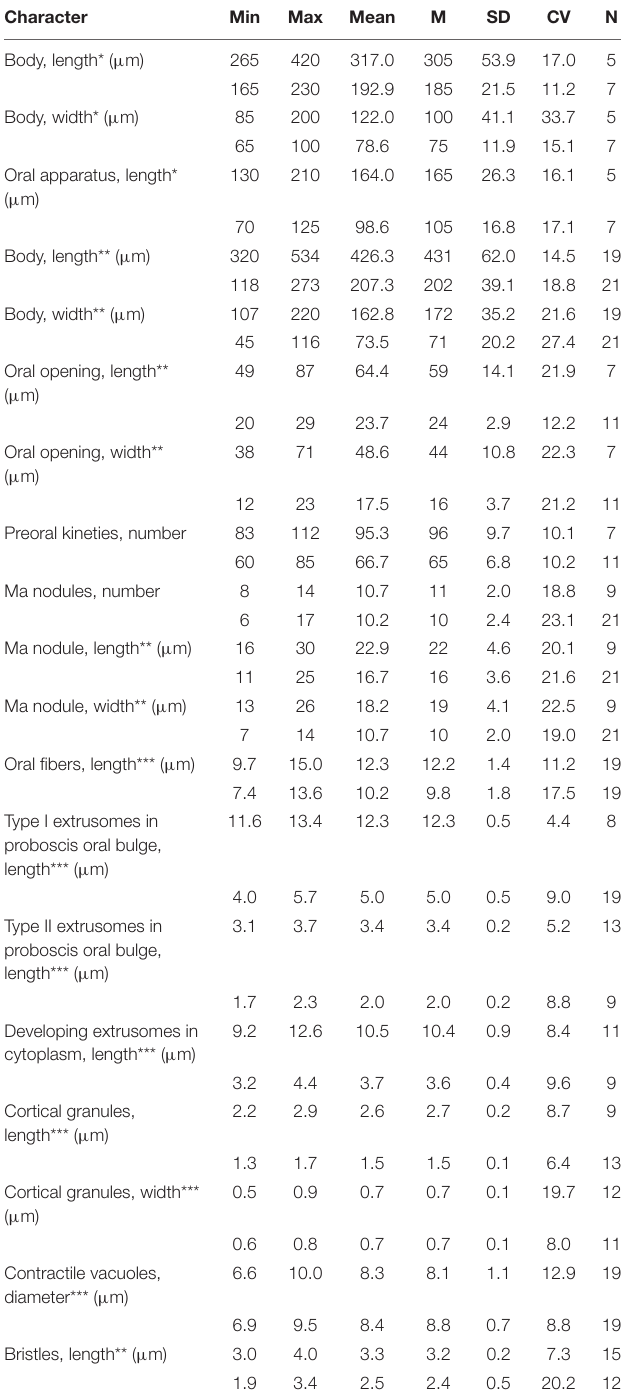
TABLE 2 | Morphometric data of Chinese populations of Paradileptus elephantinus (upper line) and P. conicus (lower line).